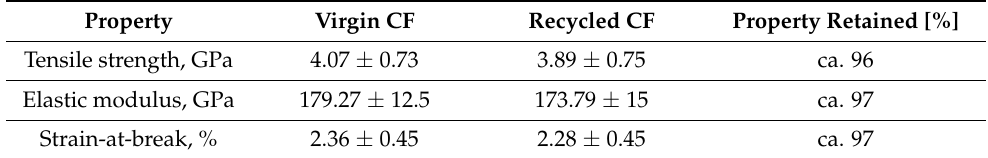
Table 4. Comparison of CF mechanical properties before and after the chemical recycling of carbon fiber/epoxy resin composites under the mild condition as described by Jianjun Jiang in [138]. Property Virgin CF Recycled CF Property Retained [%] Tensile strength, GPa 4.07 ± 0.73 Elastic modulus, GPa 179.27 ± 12.5 Strain-at-break,